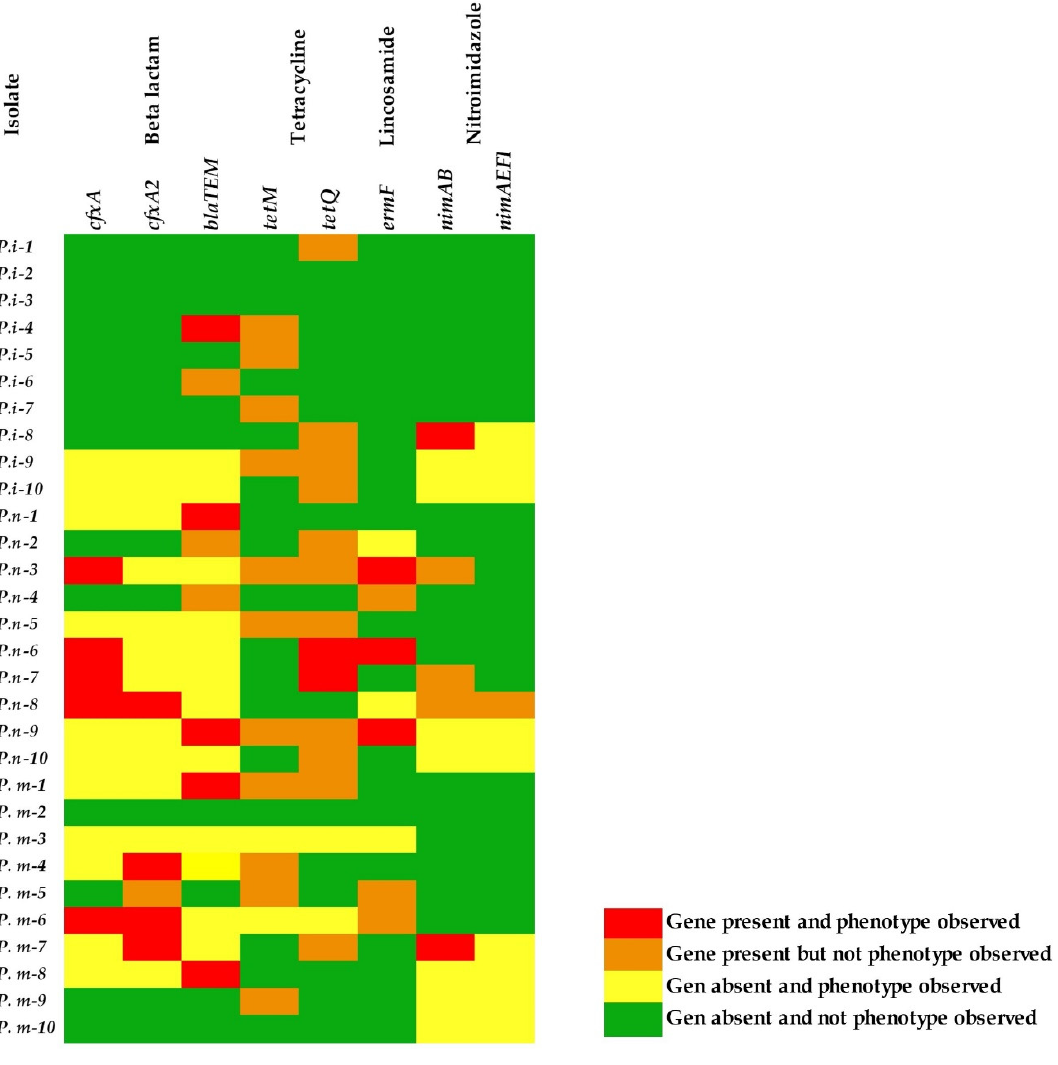
Figure 2. Heat map of the summary of the genotype–phenotype relationships of the P. intermedia , P. nigrescens , and P. melaninogenica isolates.